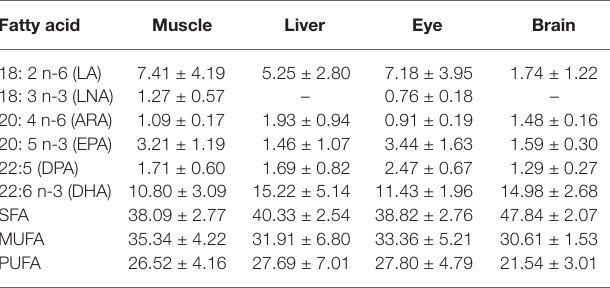
Juveniles were fed six diets for 8 weeks. Diets contained menhaden fish oil or 25:75 blends of fish oil and standard soybean oil, MUFA-enriched soybean oil, SFA-enriched soybean oil, palm oil, or poultry fat. Data represent mean ± SD from all diet treatments. LA, linoleic acid; LNA, linolenic acid; ARA, arachidonic acid; EPA, eicosapentaenoic acid; DHA, docosahexaenoic acid; DPA, docosapentaenoic acid; SFA, saturated fatty acids; MUFA, monounsaturated fatty acids; and PUFA, polyunsaturated fatty